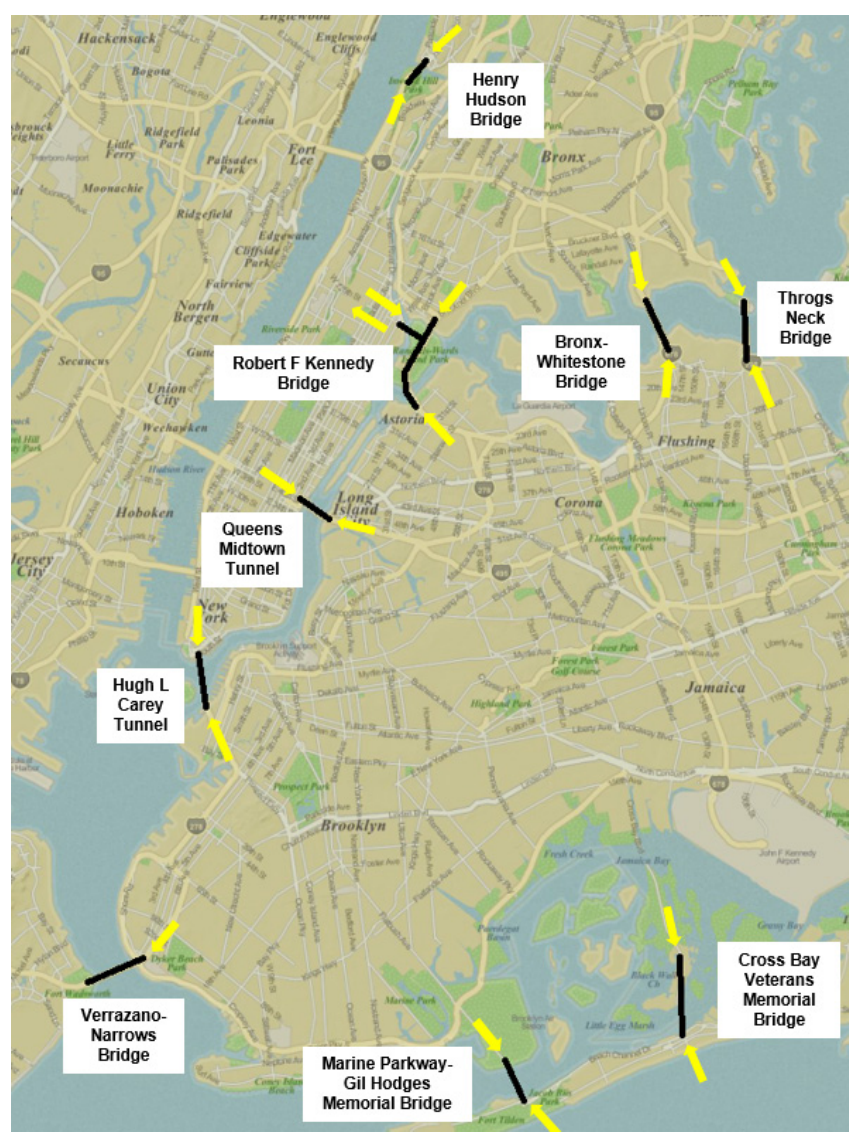
Figure 6. Output Geographic representation of the 19 traffic flows under study, in correspondence to the nine MTA bridges and tunnels.